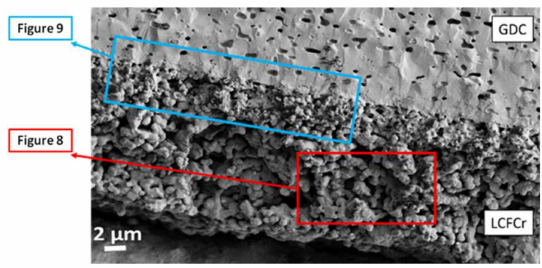
Figure 6. Back-scattered electron (BSE) image of the cross-section of the (LCFCr)/GDC interface subjected to anodic polarization after 200 h of cell testing at the open circuit potential, and then at cell potentials of 0.2 and 0.65 V all at 800 ◦ C in air. The red and the blue boxes are used to mark the locations on the cell cross-section where the samples for TEM analysis were acquired.